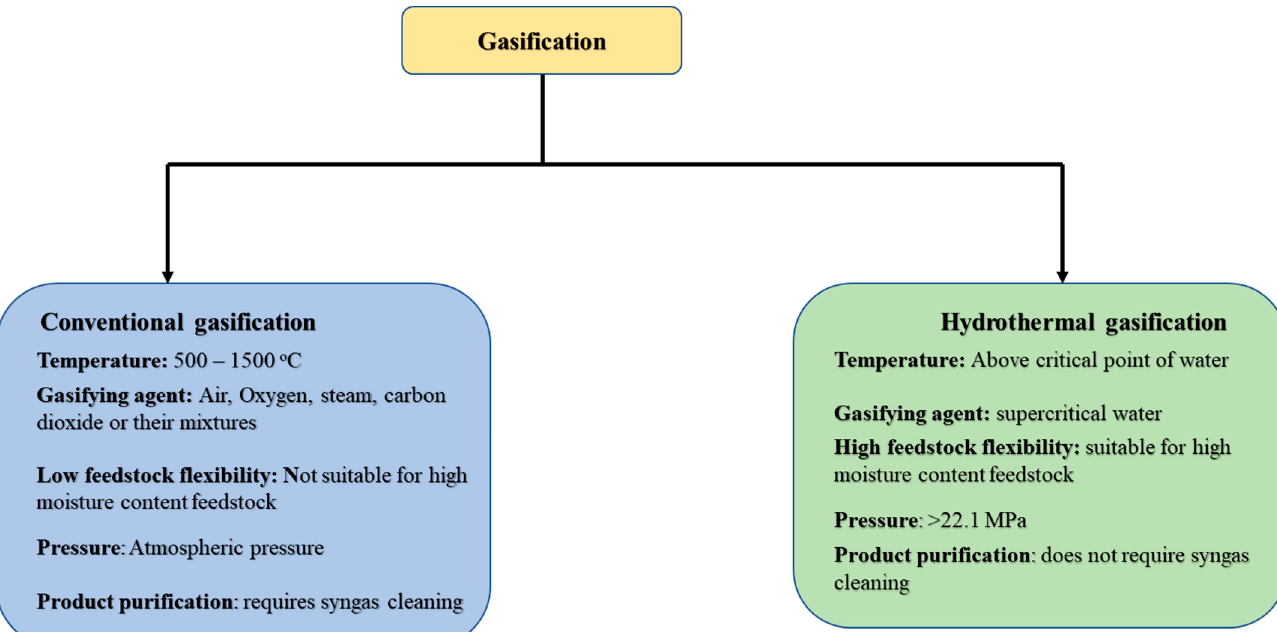
Figure 5. An overview of the difference between conventional and hydrothermal